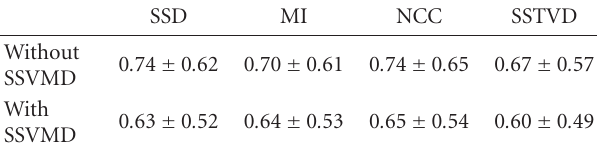
Table 4: Vessel positioning errors (mm) averaged over six subjects. SSD